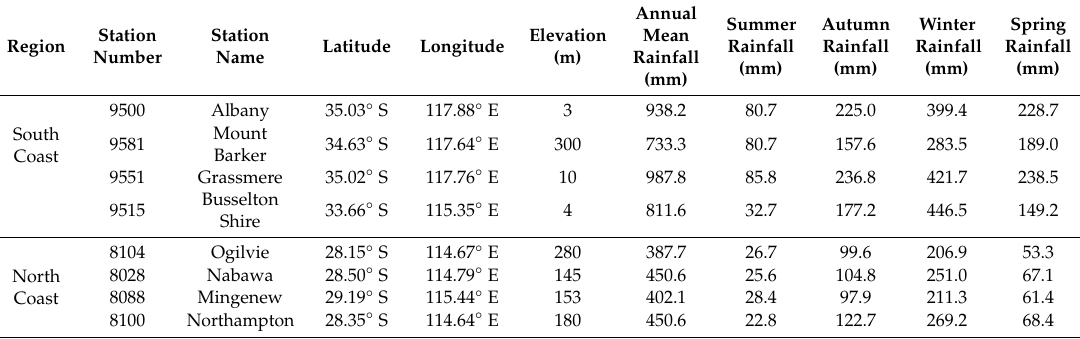
Table 1. Table 1. Table 1. Geographical location and description of rainfall Table 1. Geographical location and description of rainfall stations.